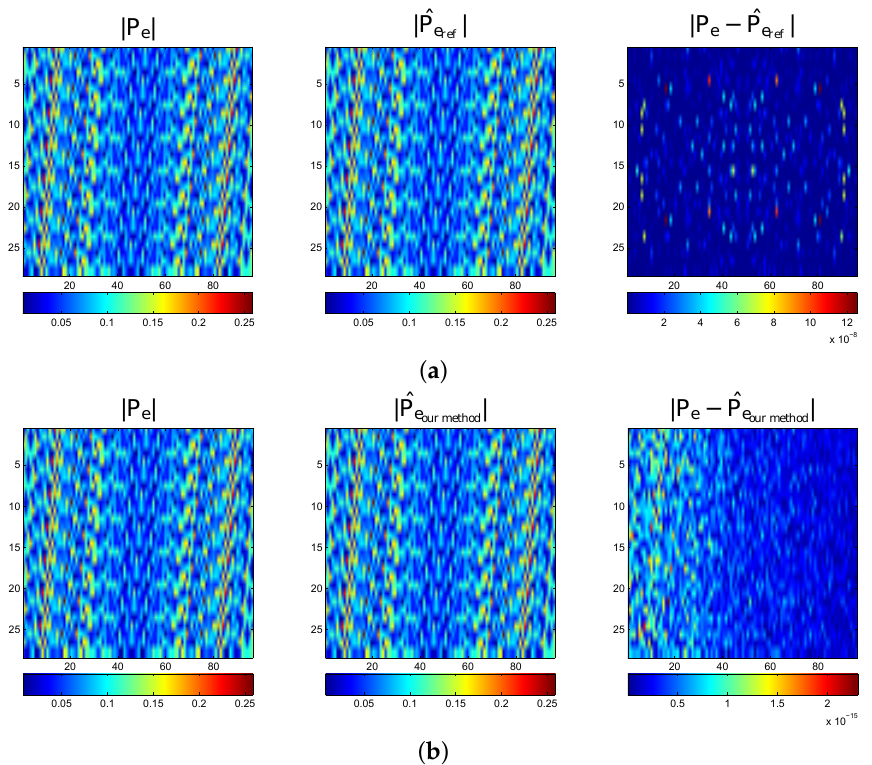
Figure 11. Comparison between theoretical matrix and calibration matrices with Matlab simulation ( left : Modulus of theoretical sensing matrix; middle : Modulus of estimated sensing matrix; right : Modulus of difference). ( a ) Reference calibration. ( b ) Our proposed calibration.